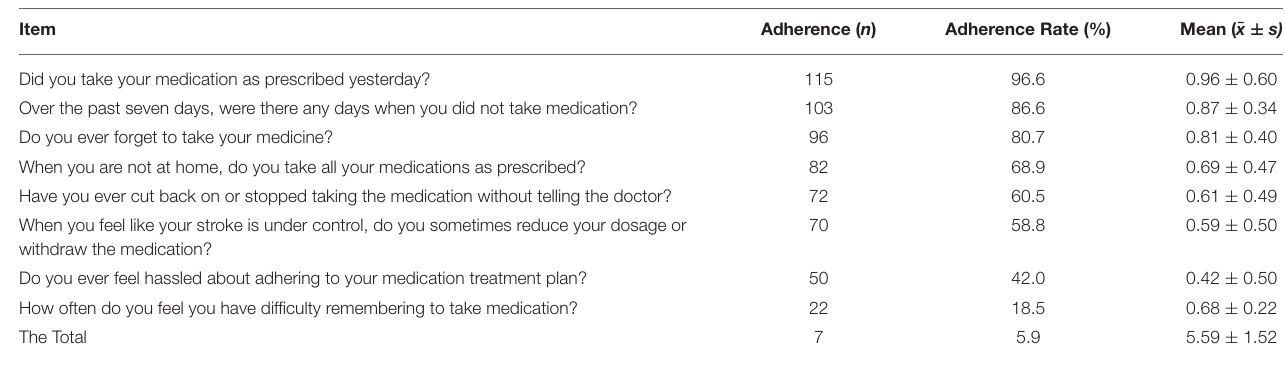
TABLE 3 | The self-reported medication adherence questionnaire scores in patients with stroke ( n =